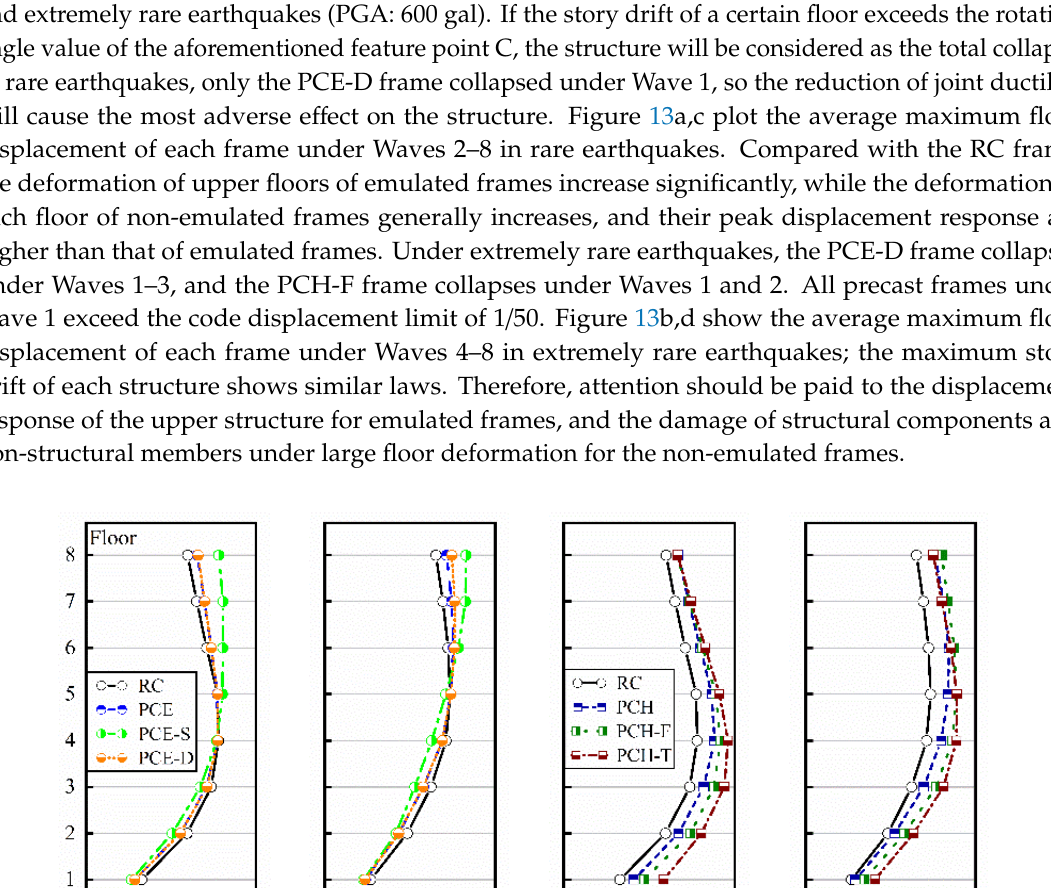
( c ) Figure 14. Time history of the top displacement under Wave 2 (PGA: 600 gal): ( a ) RC frame; ( b ) PCE frame; ( c ) PCH frame.